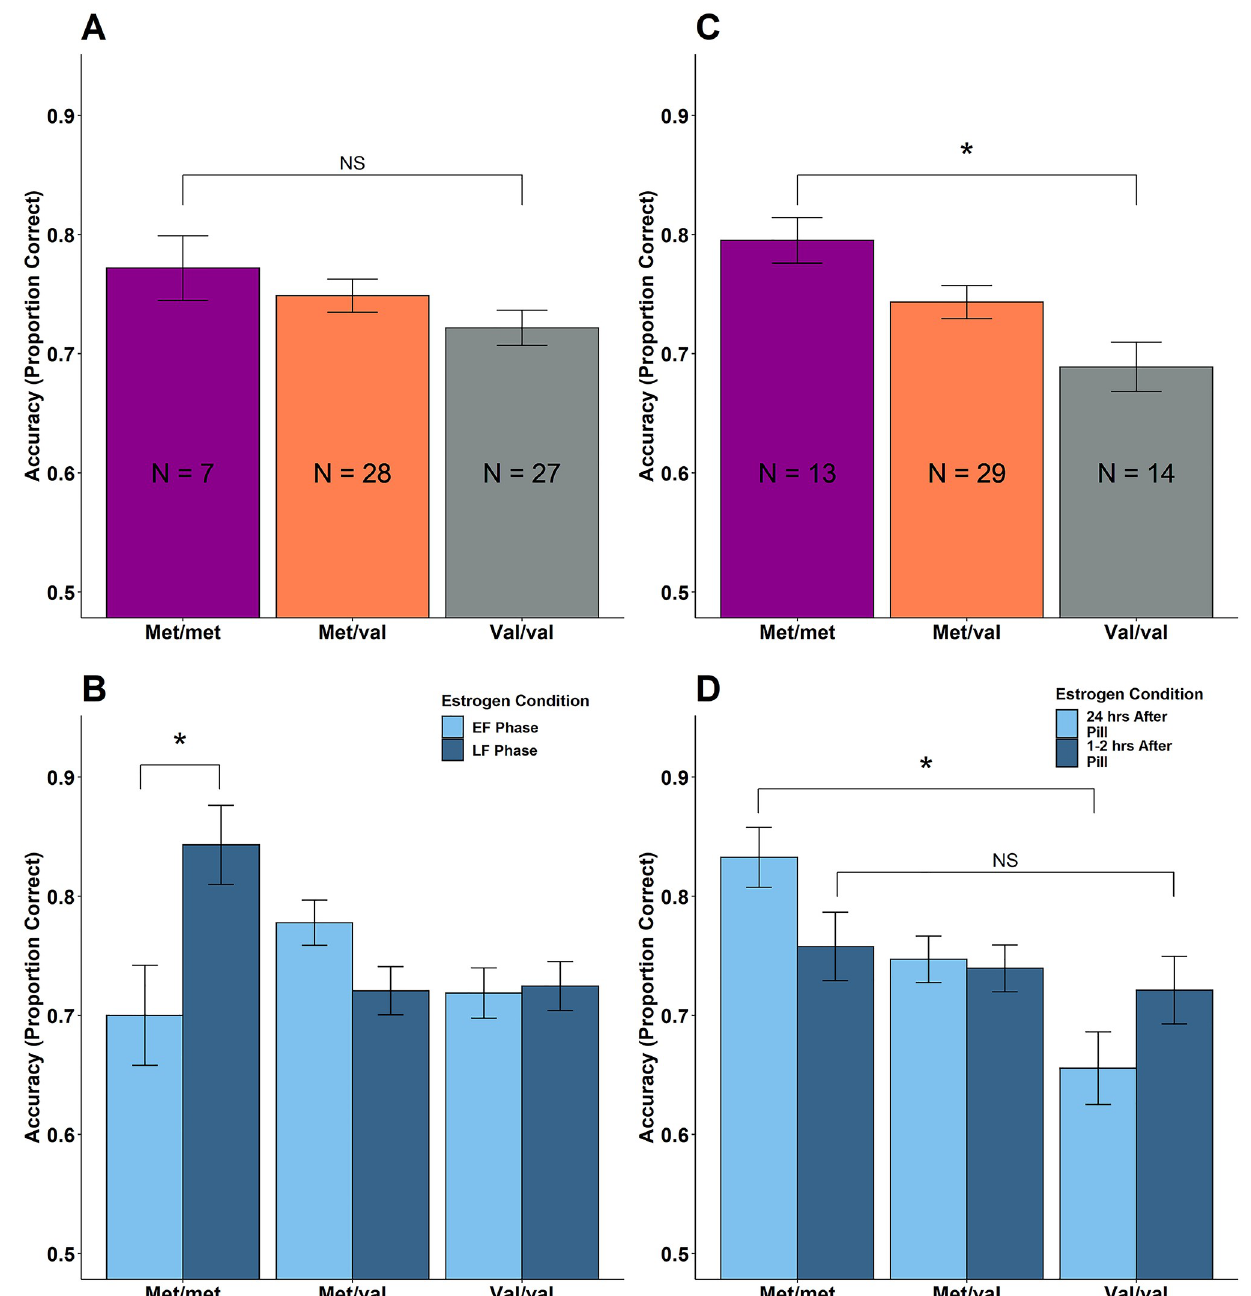
Fig 3. N-back lure accuracy is influenced by COMT , group and estrogen condition. In NOC, 2-back lure accuracy is related to the interaction of COMT and estrogen condition but in OC it is influenced by COMT alone. Reduced sample with only NOC: (A) 2-back lure accuracy was unaffected by COMT genotype; (B) met/met were significantly more accurate in the high estrogen condition (late follicular) than in the low estrogen condition (early follicular) phase, while met/val and val/val were less influenced by their estrogen condition. Reduced sample with only OC: (C) met/met had significantly higher accuracy on 2-back lures than val/val ; (D) pill time was not a significant moderator of COMT on 2-back lure accuracy, however, differences between met/ met and val/val were significant 24 hours, but not 1–2 hours, after pill ingestion. Error bar refers to SEM, � p < 0.05 Abbreviations: NS, not significant; N, sample size; EF, early follicular; LF, late follicular; hrs, hours.